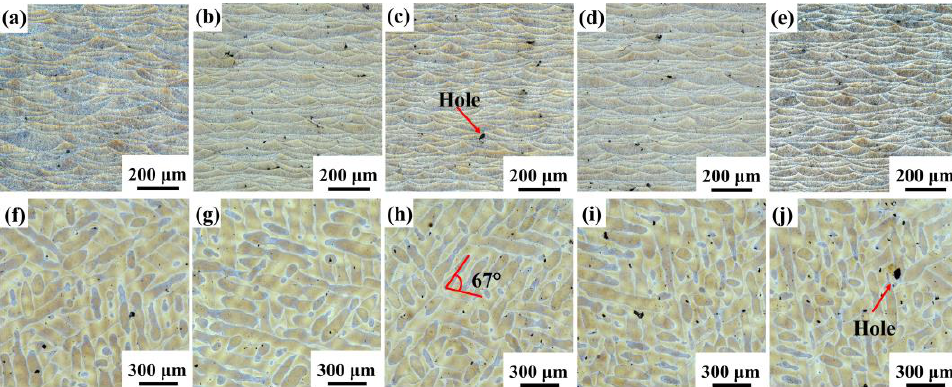
Figure 6. Optical microscopy images of S0, S1, S2, S3, and S4 samples in the ( a – e ) longitudinal section and ( f – j ) cross section; ( a , f ) S0; ( b , g ) S1; ( c , h ) S2; ( d , i ) S3; ( e , j ) S4.